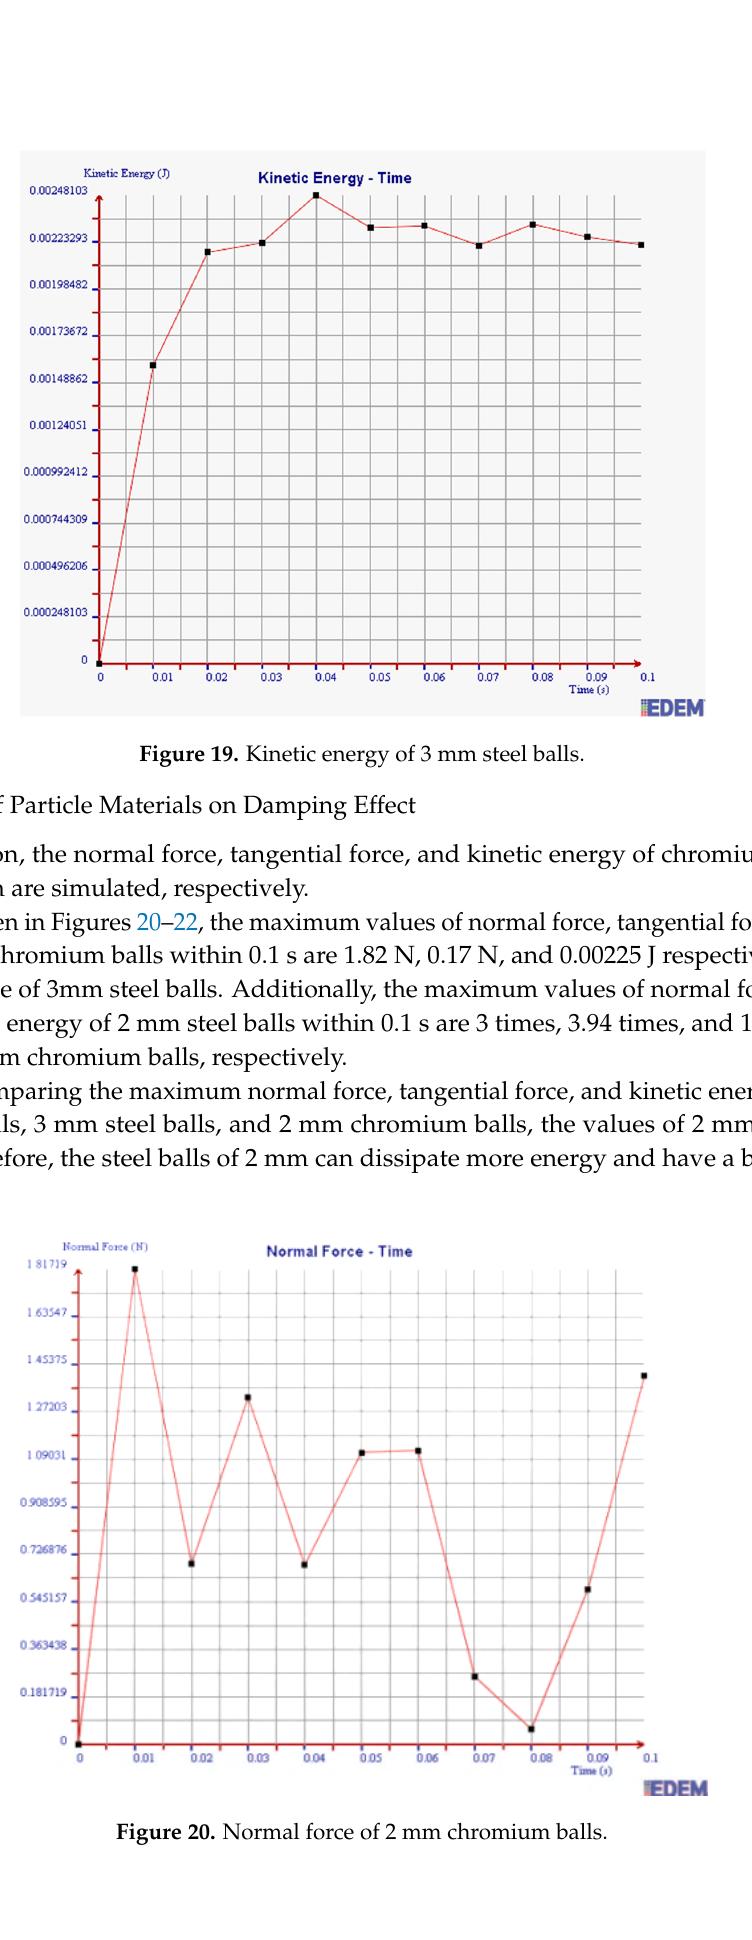
Figure 21. Tangential force of 2 mm chromium balls.